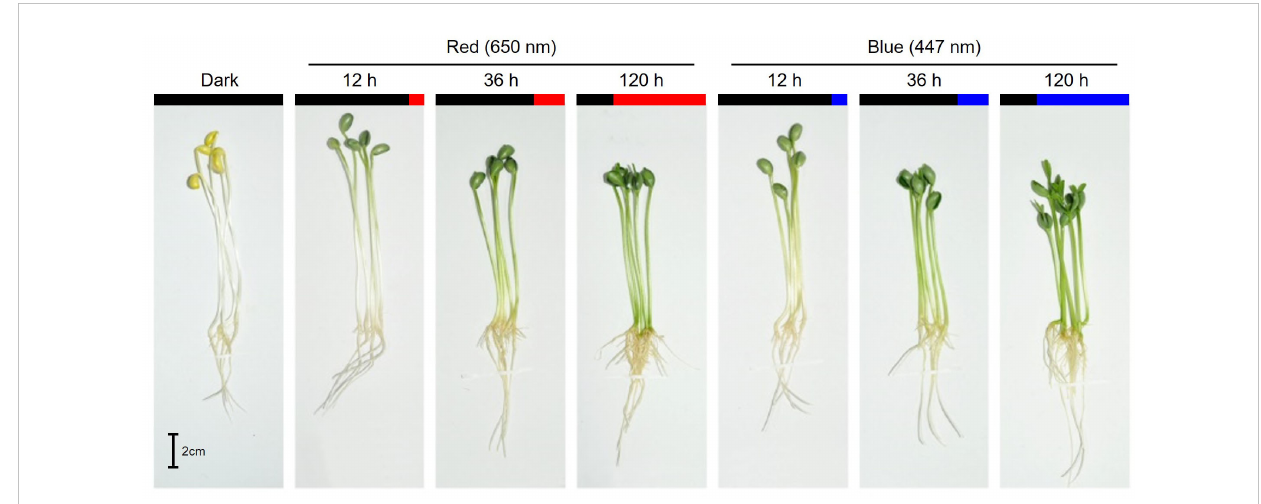
FIGURE 1 Morphology of 7-day-old soybean seedlings grown under darkness and different exposure times of red (650 nm) and blue (447 nm)